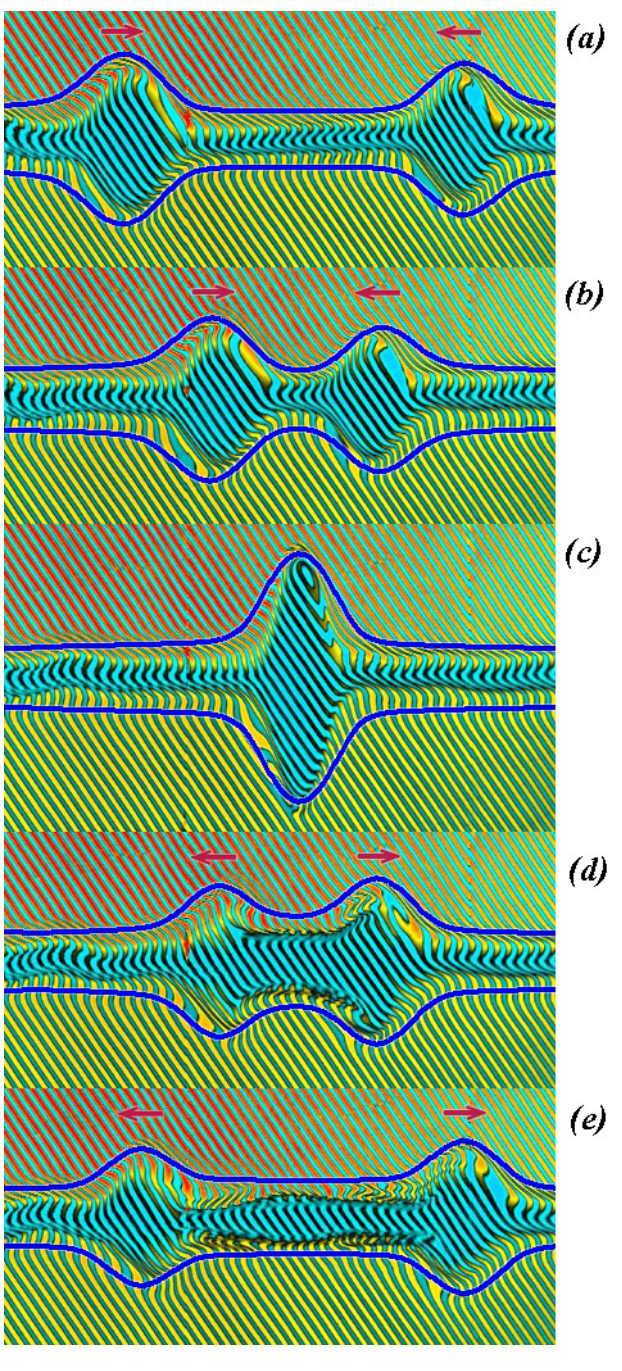
Fig. 4. Interaction of symmetric solitary waves moving toward each other. The time interval between the frames ( a–e ) is 5s. The wave parameters are given in the text. The thick (blue) curves show the calculated wave